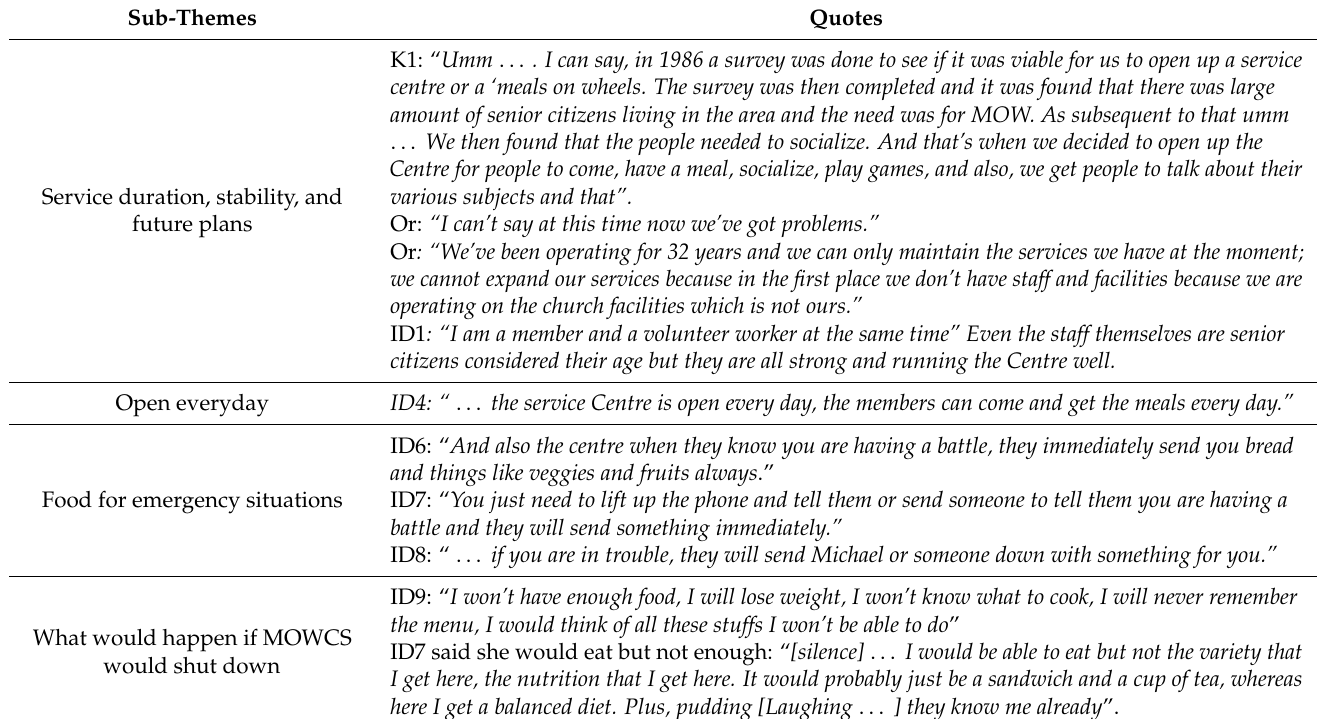
Table 4. Outcomes of food stability from data obtained from in-depth interview with key personnel and some